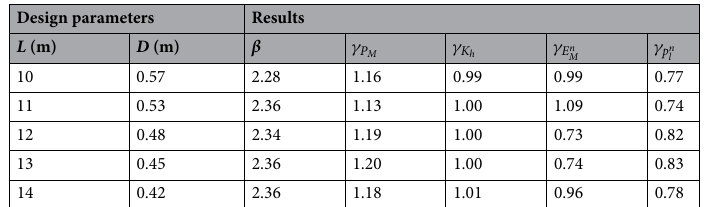
Table 3. Calibration results using first-order reliability method. L is the pile length, D is the pile diameter, β is the reliability index, γ P is the partial factor of the mechanical load, γ K M